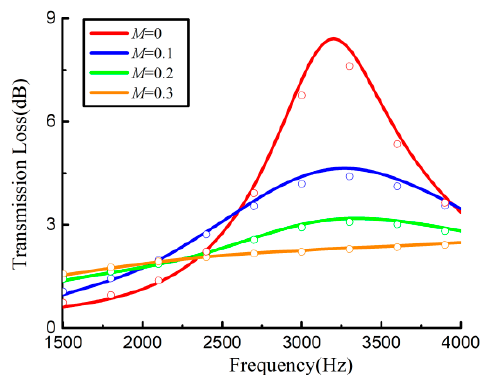
Figure 9. Transmission loss of the RDBRE system with different grazing flow Mach numbers. The